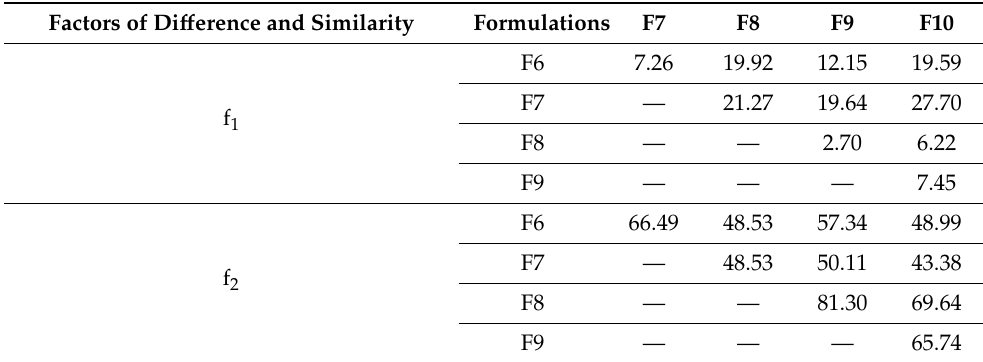
Table 3. The values of the di ff erence factor f 1 and the similarity factor f 2 obtained by comparing the release profile of 5-ASA from formulations